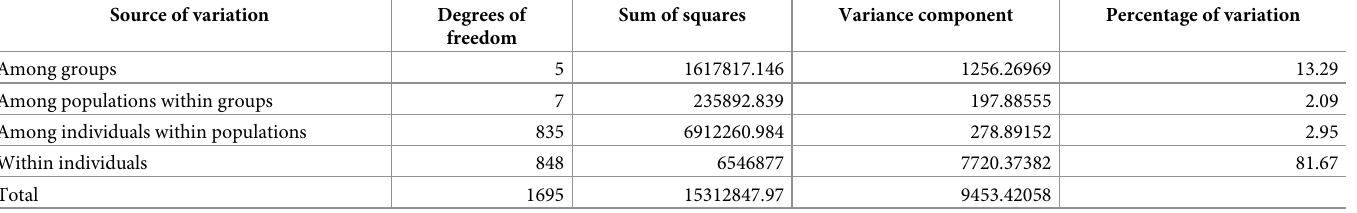
Table 4. Analysis of molecular variance (AMOVA) results for 13 goat populations in six population groups (Cameroon, Ethiopian, Cashmere, Moroccan, Egyptian, Iranian).